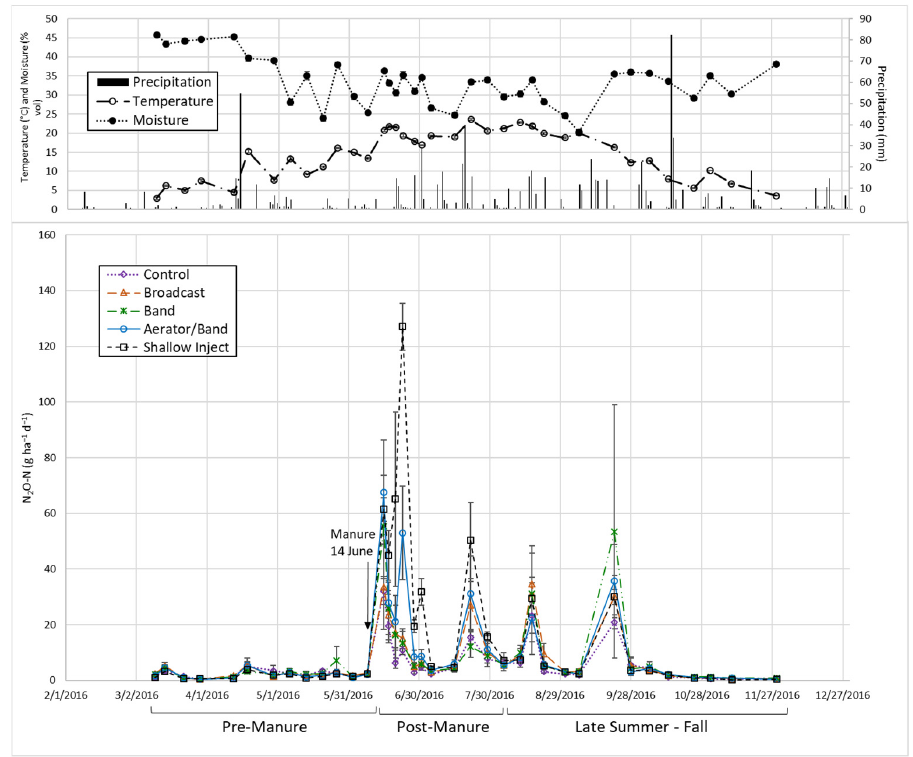
Figure 4. Precipitation, soil temperature and moisture, and daily nitrous oxide (N 2 O-N) fluxes for 2016.